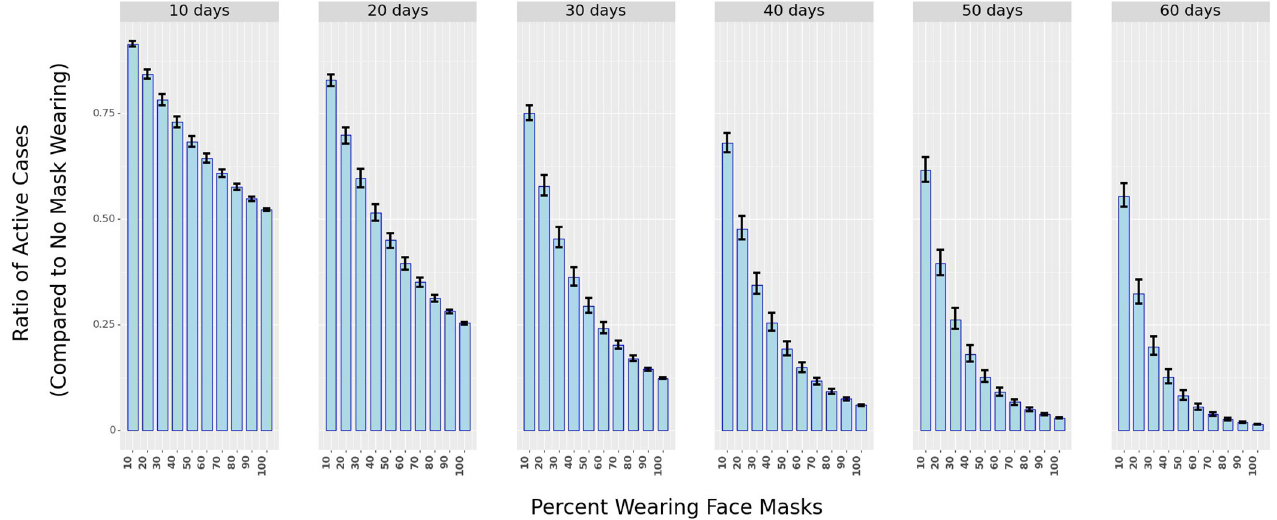
Fig 6. The ratio of active cases under different percentages of mask-wearing in public spaces as compared to 0% mask-wearing over different periods (in days). The shaded bars represent in ratio while the black vertical lines represent the 25 th and 75 th percentile of the ratio (from simulations using the Krinsky- Robb